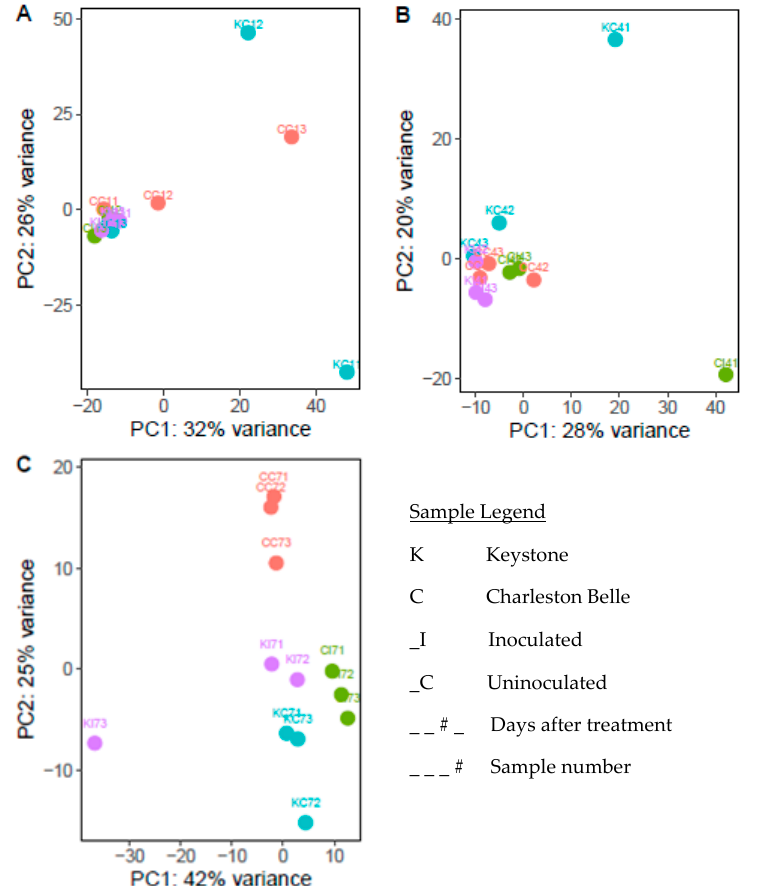
Figure 2. Principle component analysis of all samples within each timepoint. ( A ): day 1; ( B ): day 4; ( C ): day 7. Within each timepoint, samples with high variation were removed from downstream analyses. Colors denote different cultivar and nematode treatments within the same timepoint.